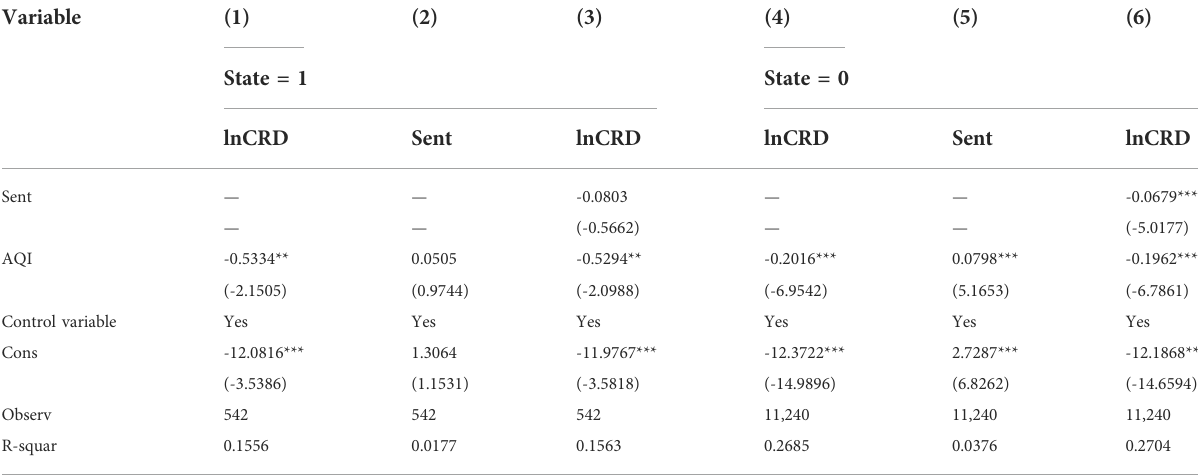
TABLE 8 Heterogeneity analysis of enterprise based on investor sentiment. Variable